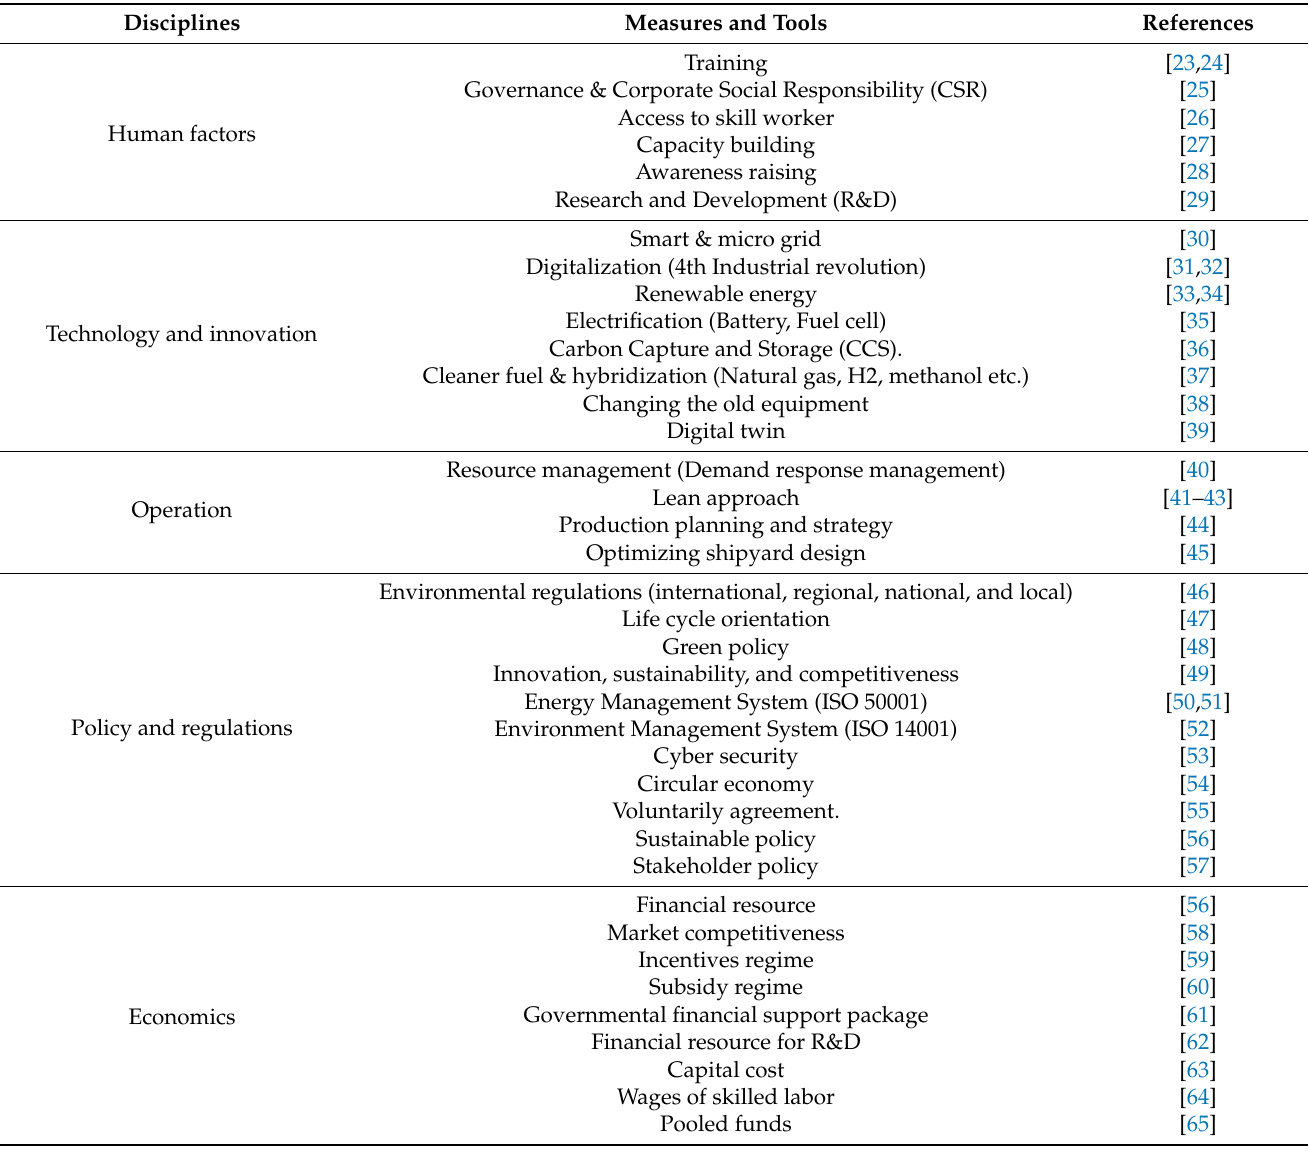
Table 1. Disciplines and related measures and tools. References